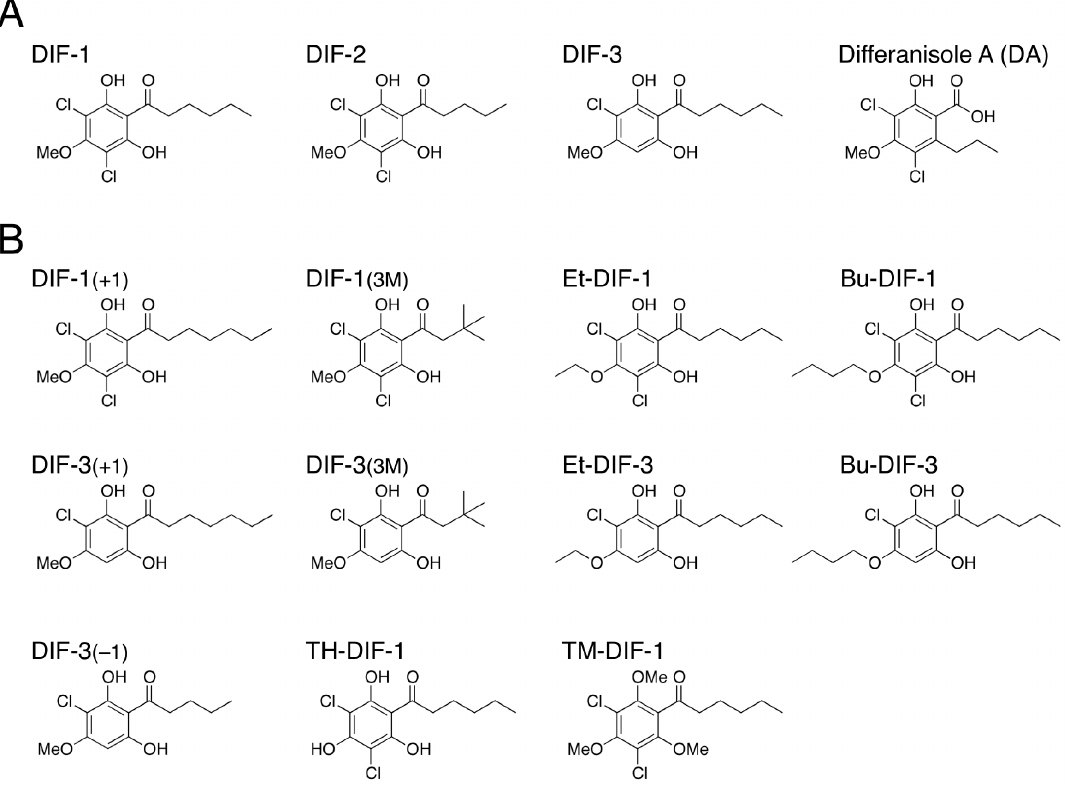
Figure 2. ( A ) Chemical structures of DIFs 1–3 and differanisole A. The order of the stalk ‐ cell differentiation-inducing activity in D. discoideum in vitro is DIF-1 > DIF-2 >> DIF-3 [39,40]; ( B ) Chemical differentiation ‐ inducing activity in D. discoideum in vitro is DIF ‐ 1 > DIF ‐ 2 >> DIF ‐ 3 [39,40]; ( B ) structures of 11 representative DIF Chemical structures of 11 representative DIF derivatives.